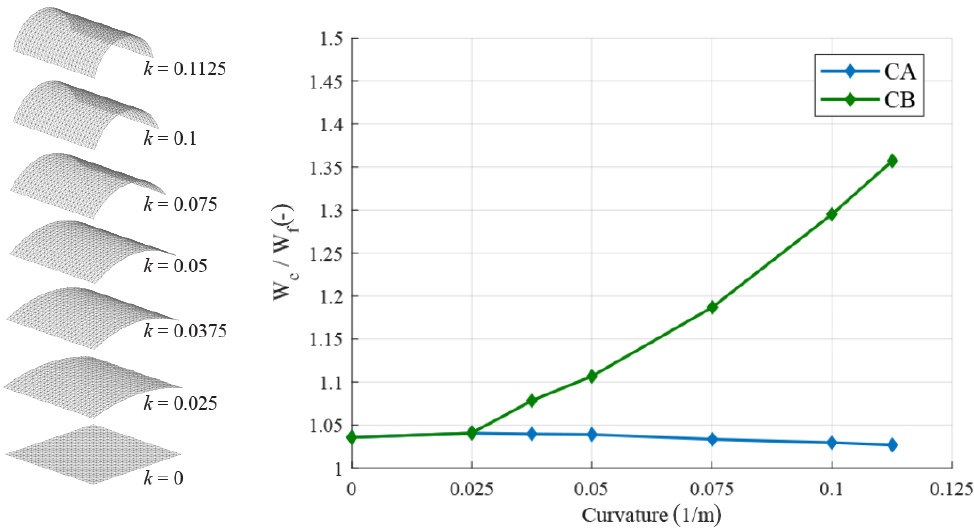
Figure 15. Percent error of CA and CB from the fine model with respect to the curvature κ = 1/ R . Being l = 1 m, in this case κ = 2 β . κ ∈ [0, 0.1125 ] m − 1